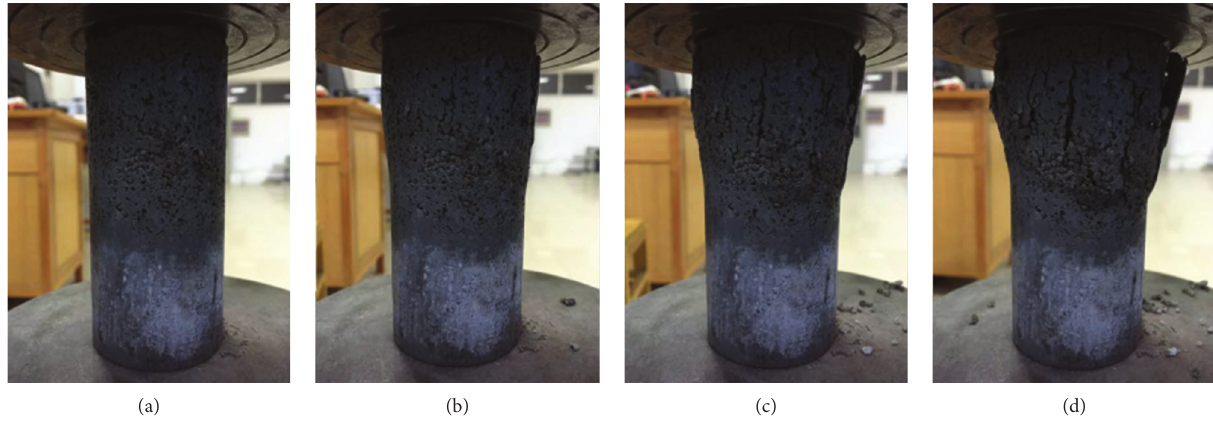
Figure 6: Local destruction pattern of the grouted body (W/C � 1.6). (a) Initial state. (b) Expansion of the upper part. (c) Expansion development. (d)